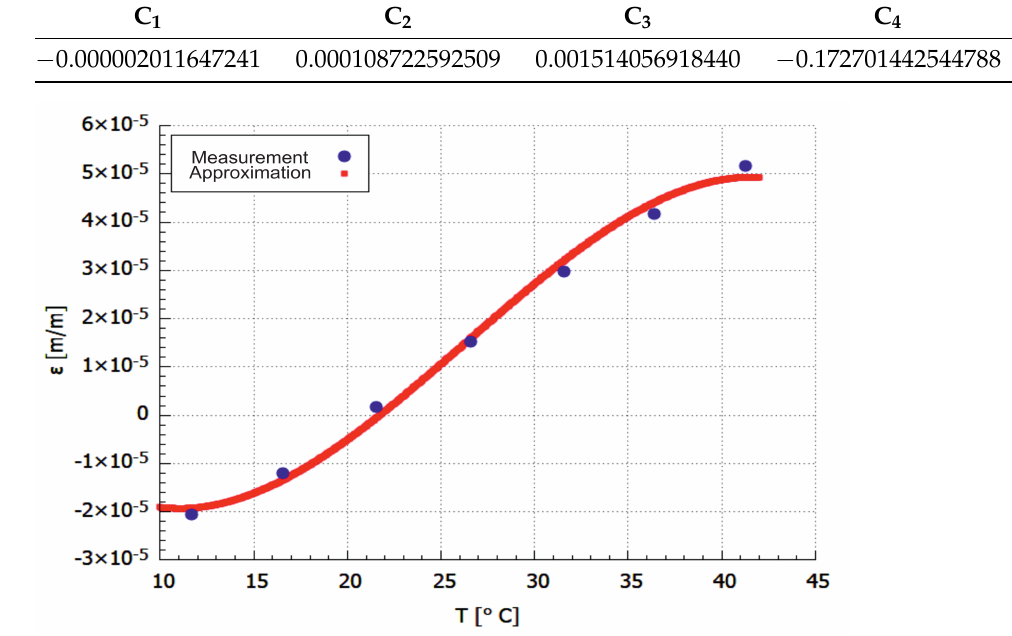
Figure 5. Strain in CFRP material determined